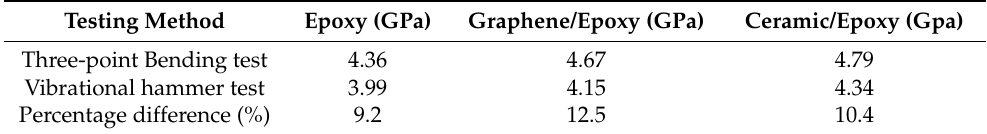
Table 6. Comparison between Three-point bending and Vibrational hammer